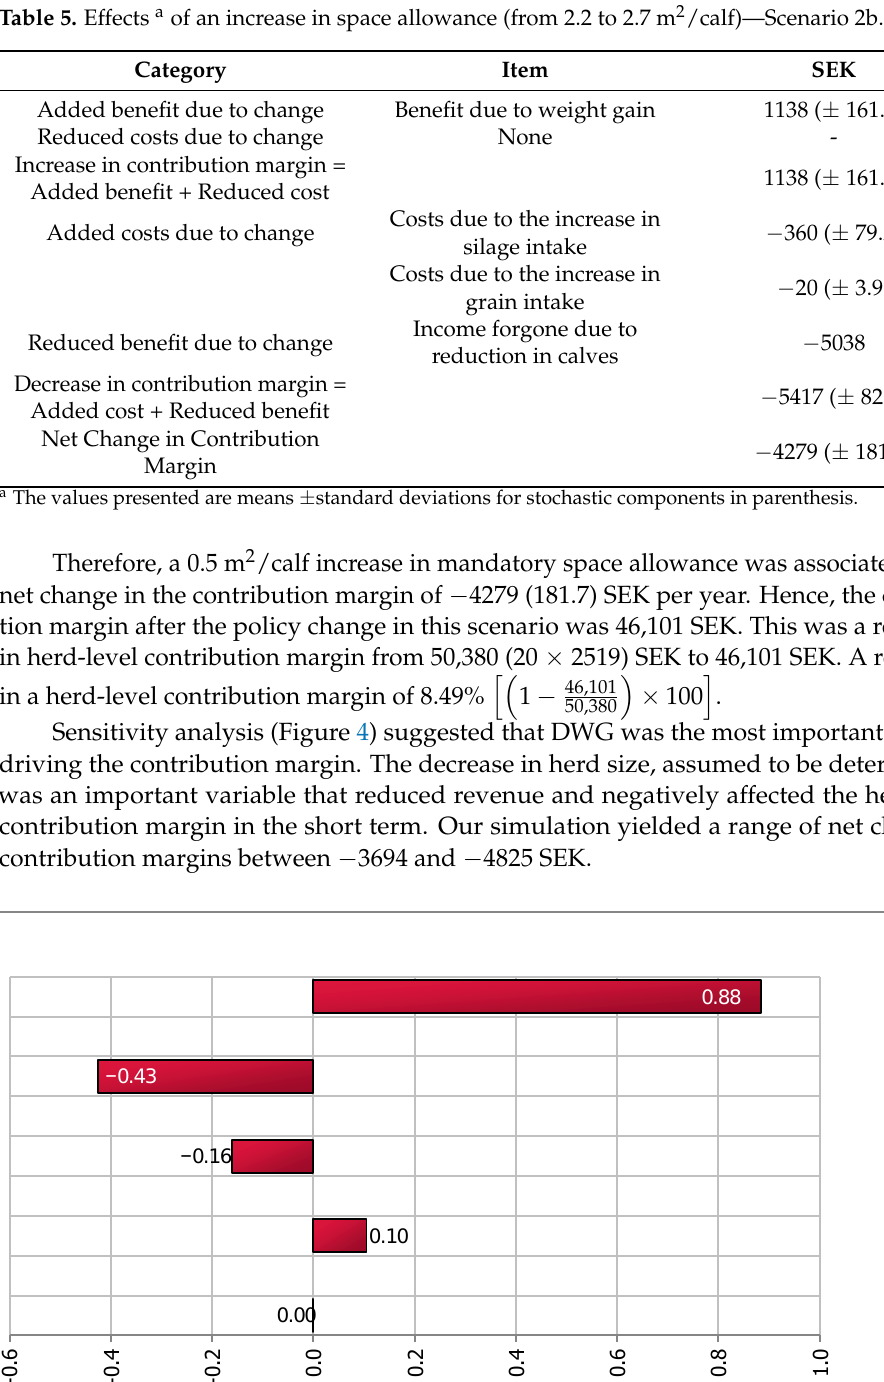
Table 5. Effects a of an increase in space allowance (from 2.2 to 2.7 m 2 /calf)—Scenario 2b.